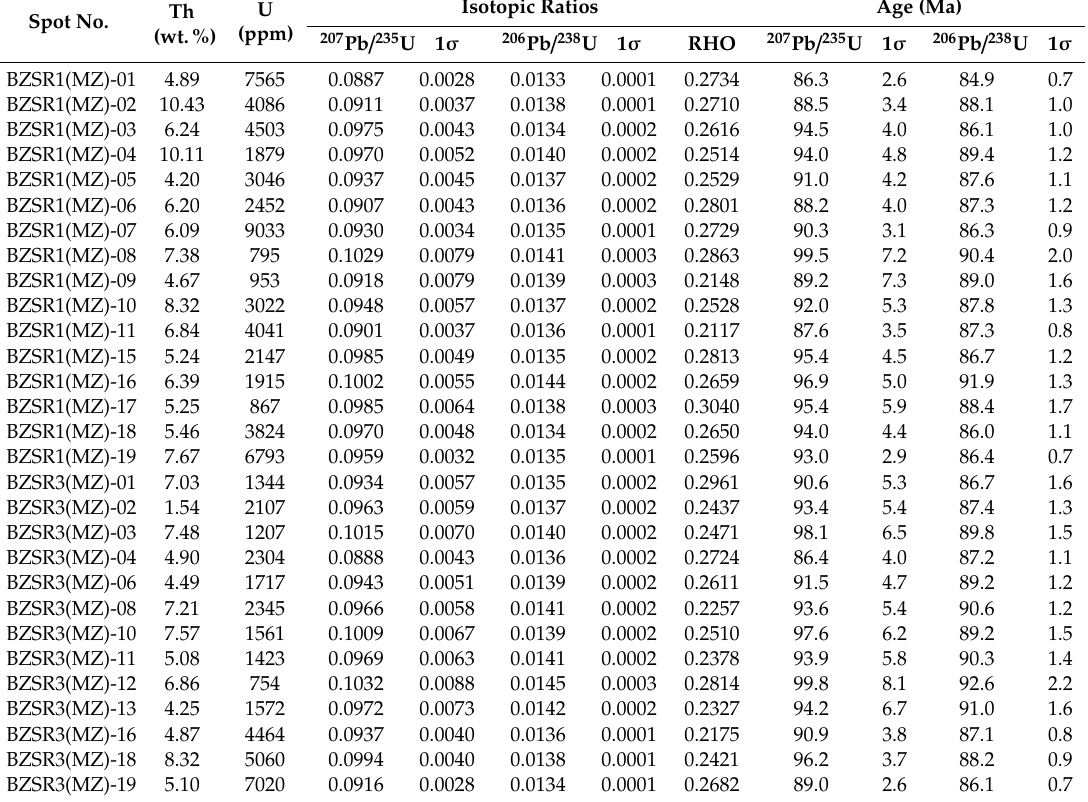
Table 2. LA-ICP-MS monazite U–Pb isotopic data of the Bozhusuan batholith. Spot